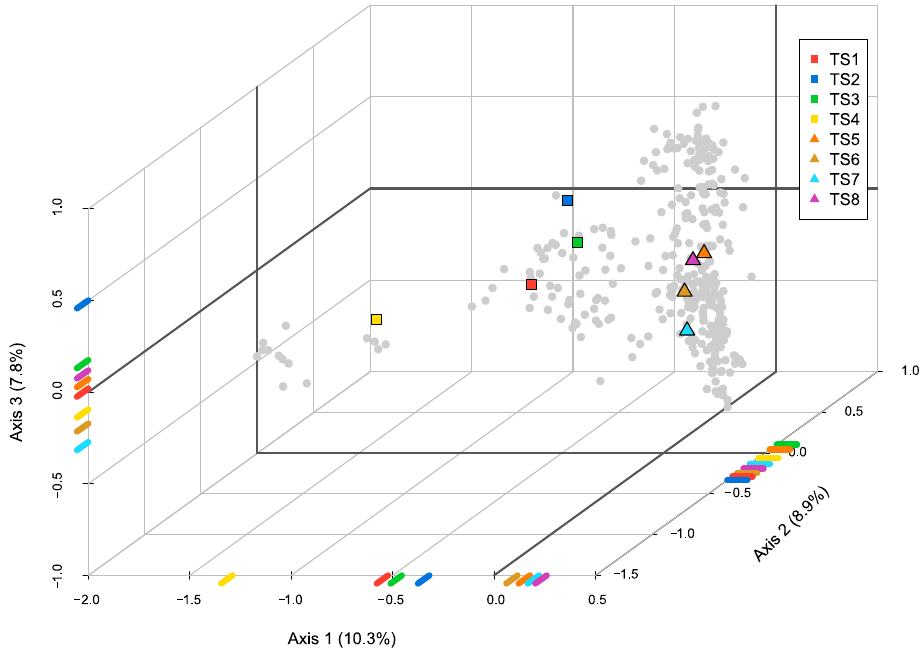
Figure 6. Results of the fuzzy correspondence analysis (FCA) applied to the macroinvertebrate “species × trait” table. The average paragons best representing each trait syndrome have been projected—as supplementary individuals—on the space defined by the first three factorial axes (total explained variance in %). TSi corresponds to the trait syndrome i (with i = 1–8) identified by cluster analysis (Figure 3). Squares and triangles correspond to TS with mainly positive or negative correlations with micropollutants, respectively. Tags indicate the position of each paragon on the different axes.